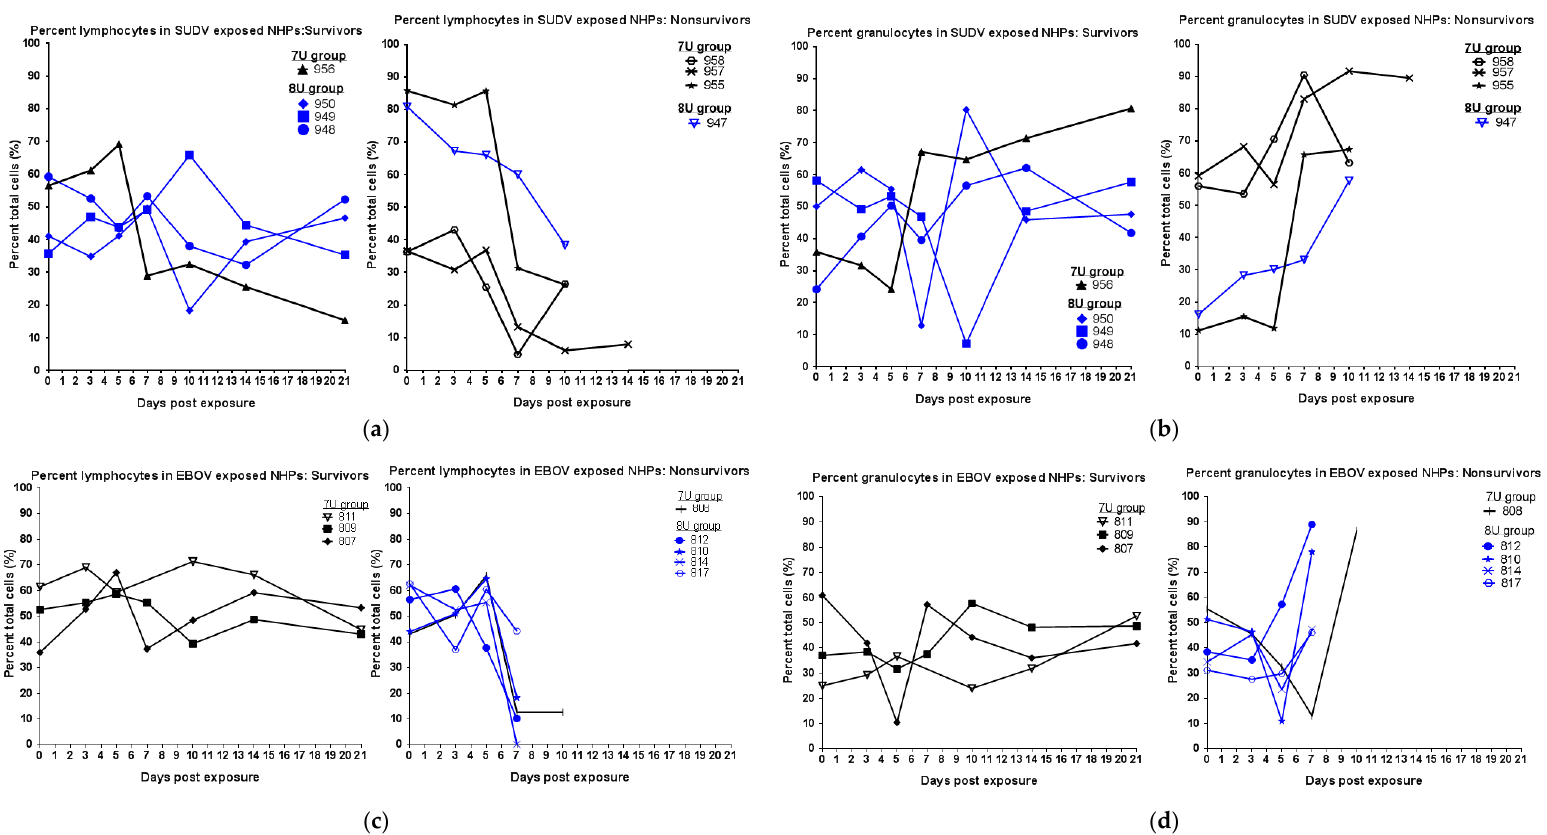
Figure 3. Lymphocyte and granulocyte percentages in Macaca fascicularis exposed to low doses of Sudan virus (SUDV) or Ebola virus (EBOV). M. fascicularis were experimentally exposed to 0.01 plaque-forming units of either SUDV or EBOV with 7-uridine (7U) or 8-uridine (8U) genotype. During each scheduled sedation, and when possible at the time of death, blood specimens were collected and analyzed. Results of hematology analysis for all animals throughout the course of the study are shown. Normal values determined at the Texas Biomed clinical pathology lab—Lymphocytes: 43–77% and Granulocytes: 19–52%. NHPs—nonhuman primates. ( a ) Percentage of lymphocytes in SUDV-exposed NHPs. ( b ) Percentage of granulocytes in SUDV-exposed NHPs. ( c ) Percentage of lymphocytes in EBOV-exposed NHPs. No data are available for animal 811 on day 7 post-exposure. ( d ) Percentage of granulocytes in EBOV-exposed NHPs. No data are available for animal 811 on day 7 post-exposure.